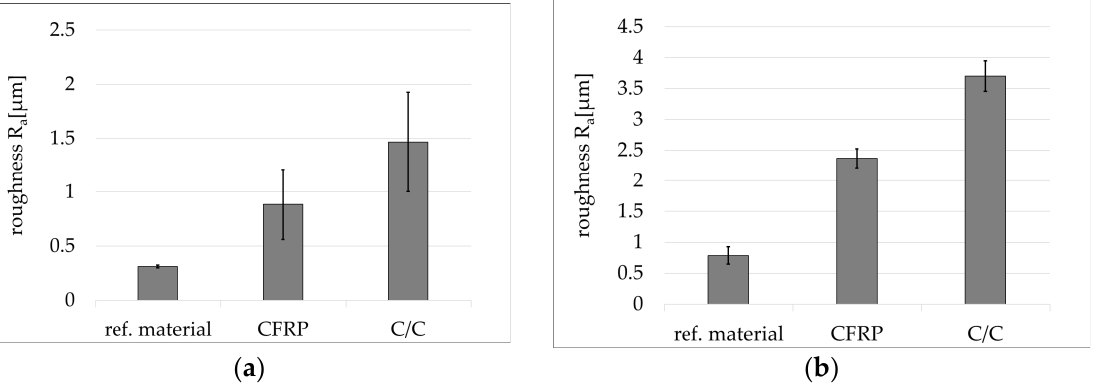
Figure 5. Roughness for different development stages: ( a ) longitudinal direction; ( b ) transversal direction. Reference material is glass-fiber-reinforced epoxy from the same